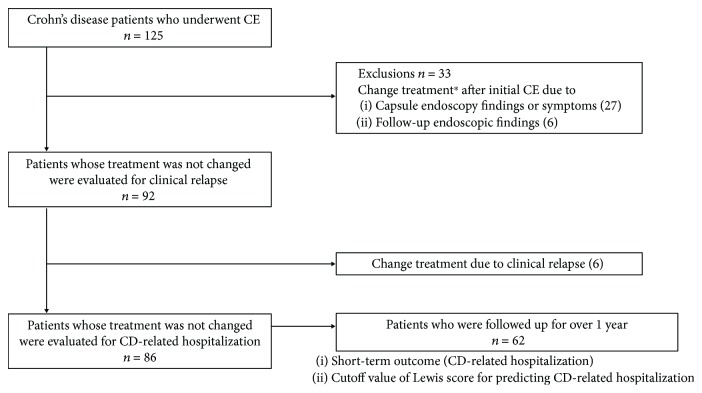
Selection of patients. ∗Addition of therapeutic drug, switching of anti-TNF-α agent, and dose escalation of anti-TNF-α agent or immunomodulators.